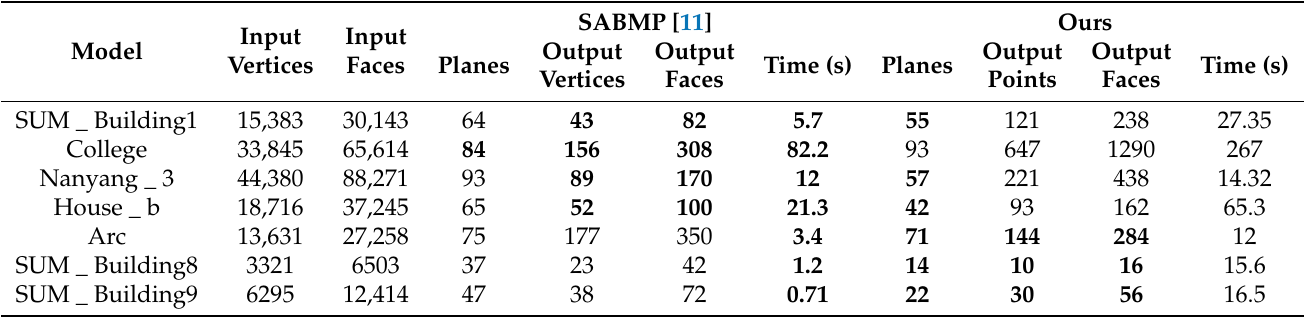
Table 1. Information about the simplified polygonal meshes. The polygonal meshes have been previously triangulated for